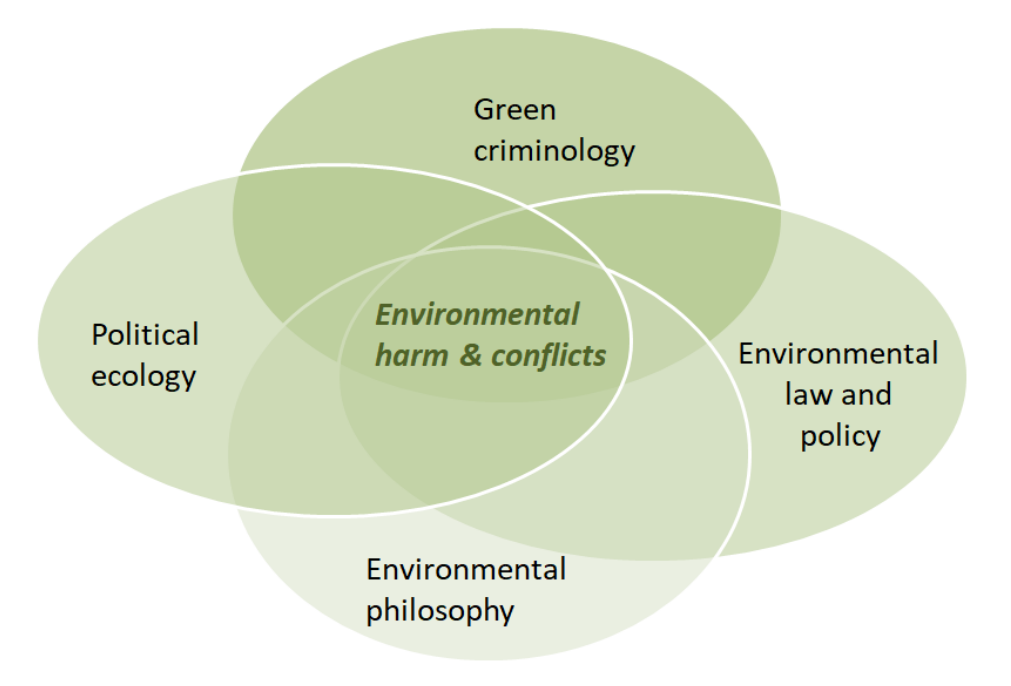
Figure 1: Interdisciplinarity, green criminology and the study of environmental conflicts. The shading of each area is intended solely for visual aid. Other relevant disciplines (such as ecology and environmental sciences) could be added to the sketch but were left out for